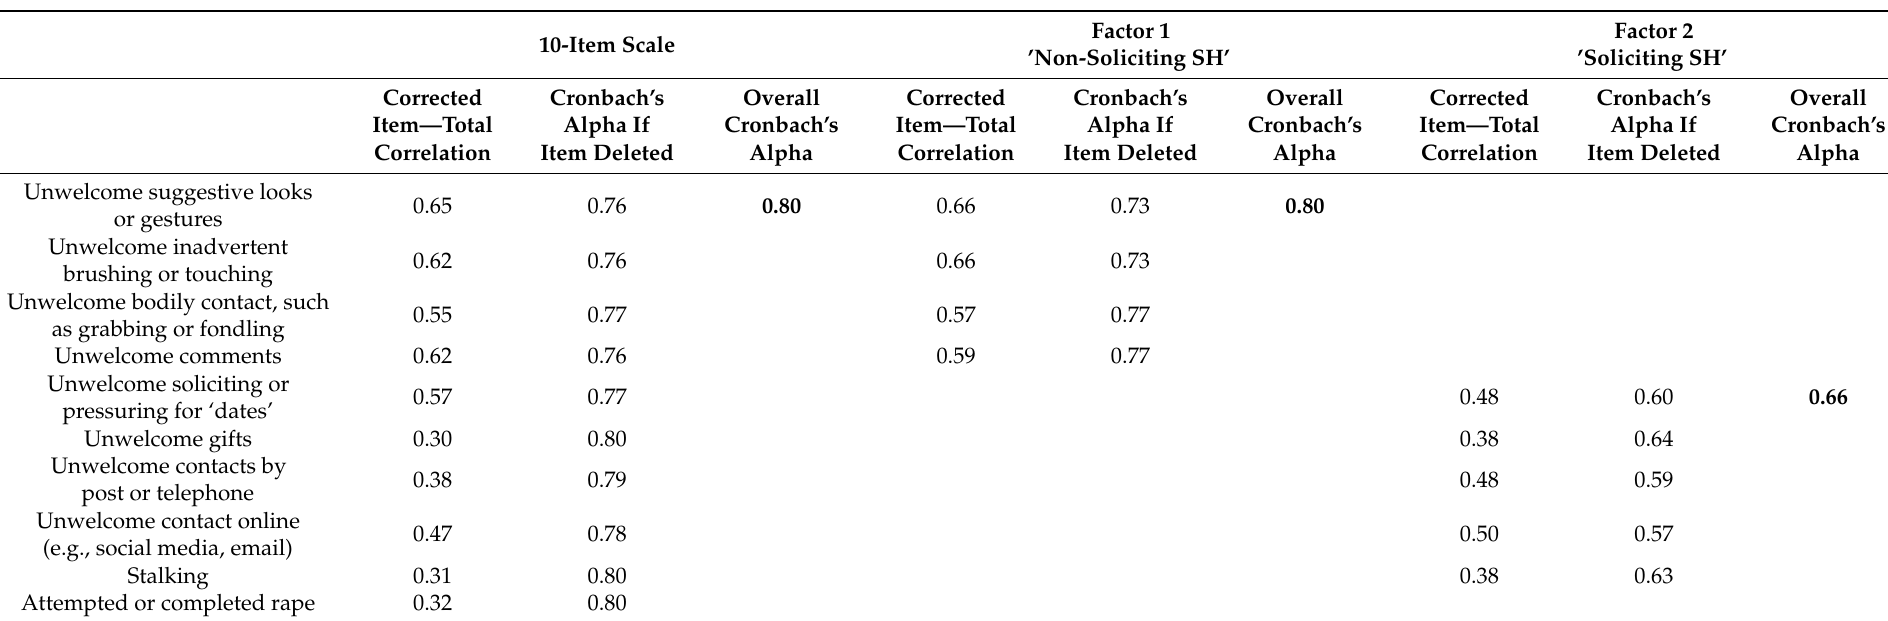
Table 5. Reliability of the 10-item scale, the ‘non-soliciting sexual harassment (SH)’ subscale, and the ‘soliciting SH’ subscale. Tellus survey, N = 12,403. 10-Item